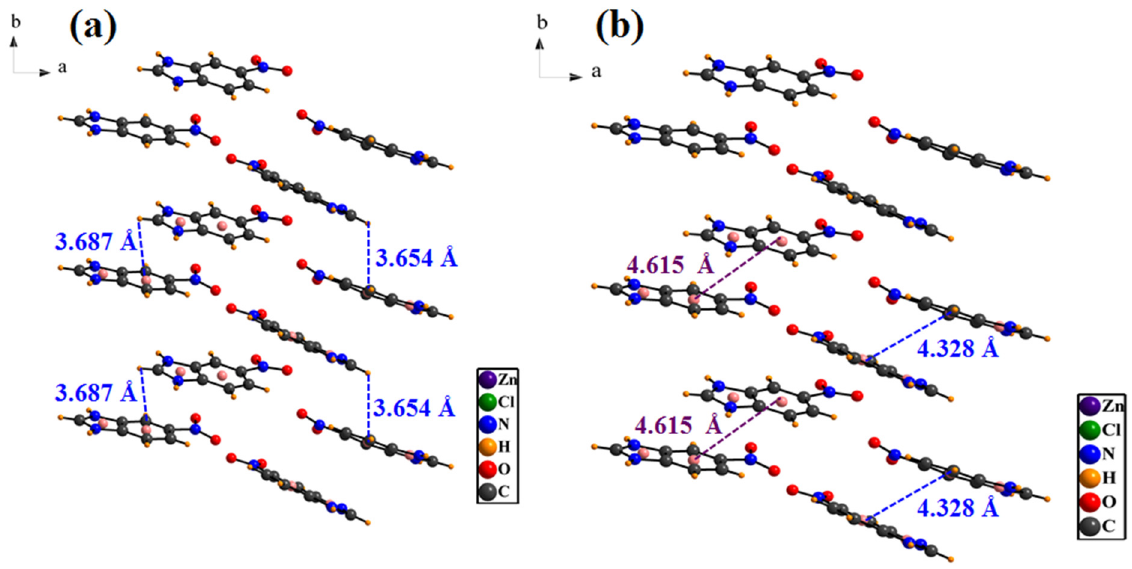
Figure 3. ( a ) C–H… π interactions ; ( b ) π … π interactions. Figure 3. ( a ) C–H . . . π interactions; ( b ) π . . . π interactions.